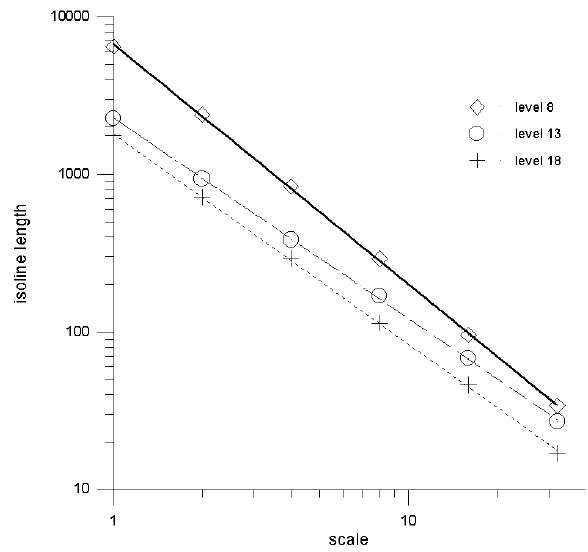
Fig. 3. Number of boxes covering the isoline as a function of box scale for isolines presented in Fig.